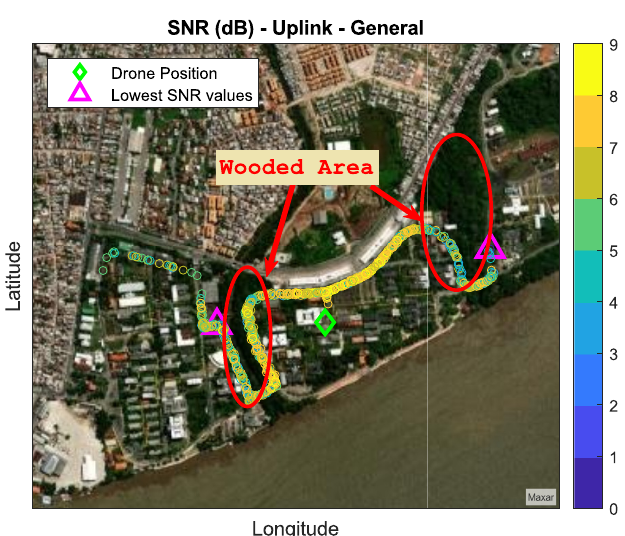
Figure 7. Uplink measured